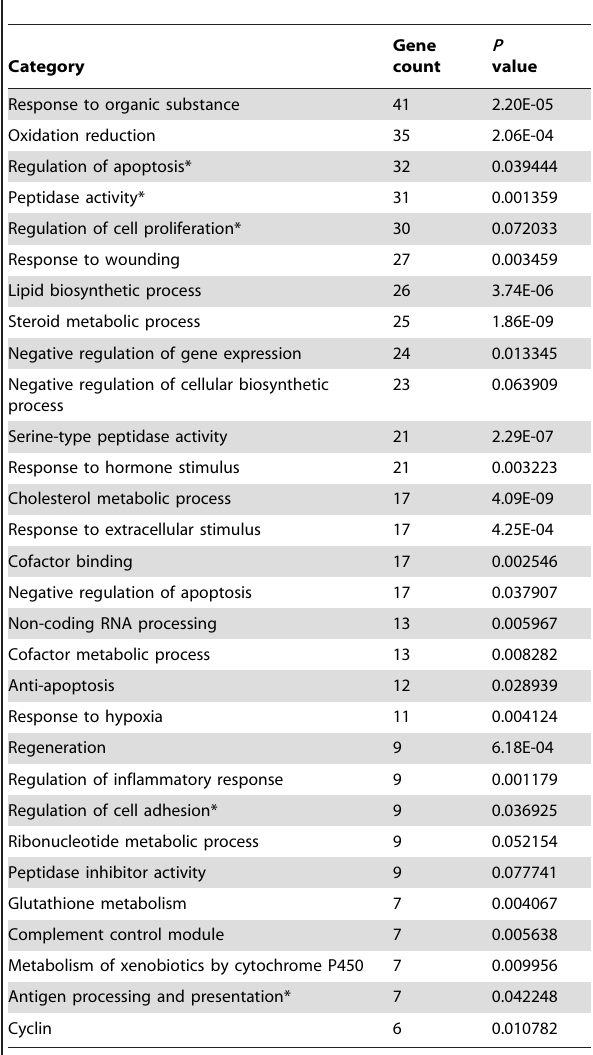
Table 1. Selective presentation of 30 functional categories of the 618 probe sets by gene ontology.